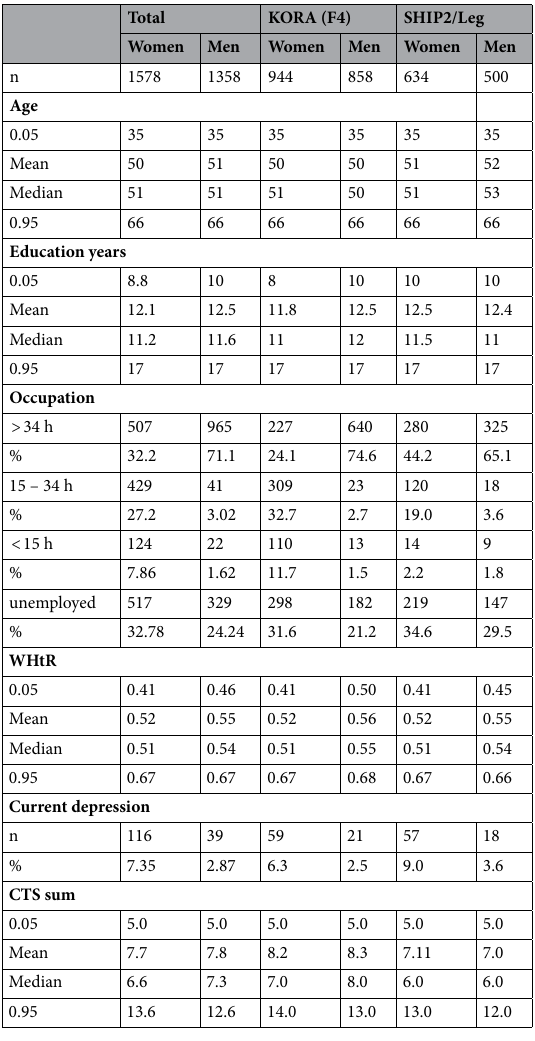
trauma categories (each with 5 levels). Depression was defined by the PHQ-9 = Patient Health Questionnaire (KORA) and BDI-2 = Beck Depression Inventory-II (SHIP). Sum scores were taken and binarised none-mild vs moderate to severe depression. For further information see